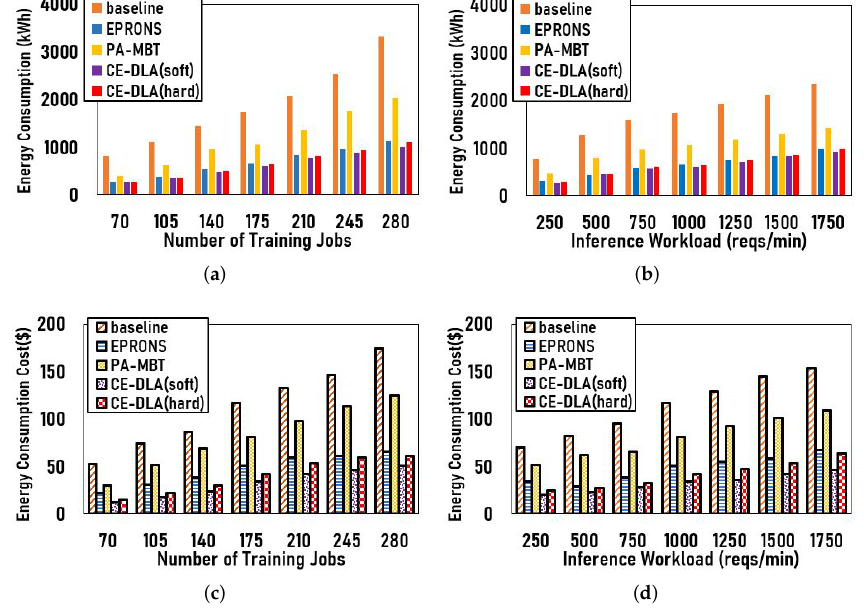
Figure 5. Energyconsumptionandcost.( a , c ):forinference = 1 × 10 5 (reqs/min).( b , d ):fortraining =